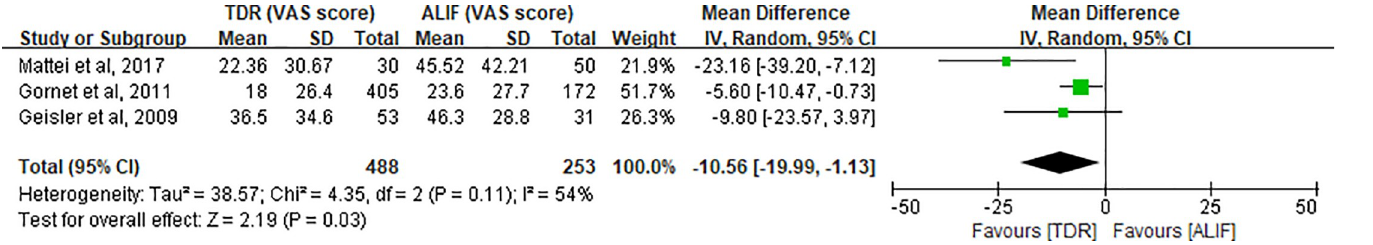
Fig 5. Forest plot for VAS score at the final follow-up. df = degrees of freedom, and IV = Inverse Variance.